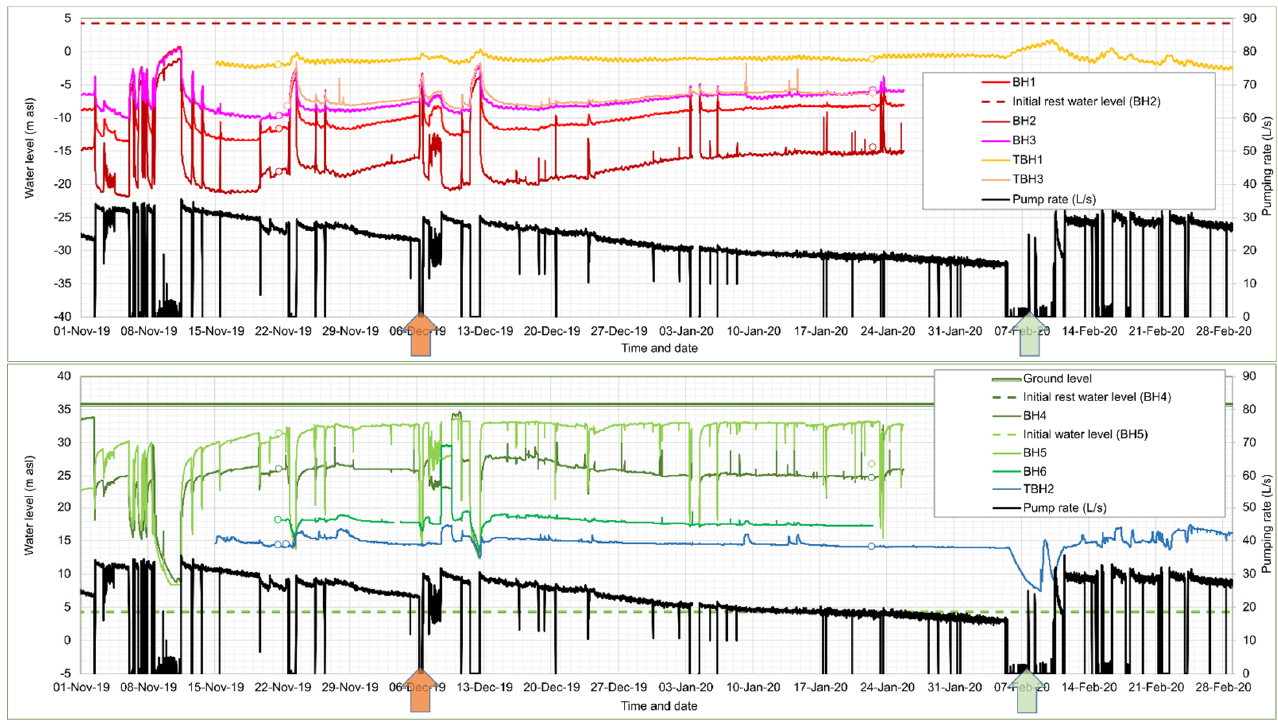
Figure 4. Operational monitoring of the Abbotsford Road site from November 2019 to February 2020. The arrows represent citric acid flushing of the plate heat exchanger of 6 December 2019 and oxalic acid cleaning and rehabilitation of BH2 around 7 February 2020. Small circles represent manual dips to calibrate automatically logged data. During the period, only BH2 was operating as an abstraction well, and only BH4 and BH5 as reinjection wells.